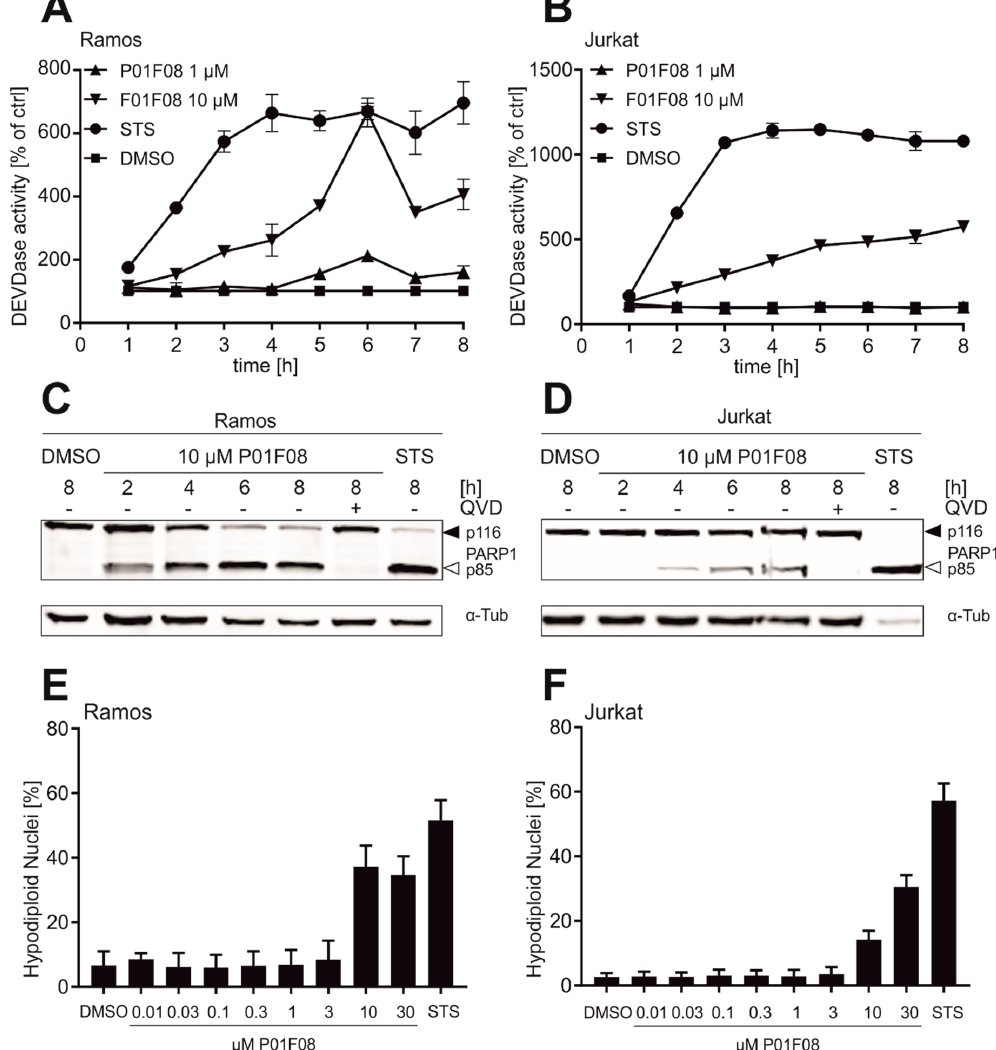
Figure 8. P01F08 is a potent inducer of apoptosis in leukemia and lymphoma cells with short latency and rapid kinetics especially in Ramos (lymphoma) cells. Ramos ( A ) and Jurkat ( B ) cells were treated with a high concentration of P01F08 (10 µM) or staurosporine (STS; 2.5 µM; positive control) for the induction of apoptosis for 8 h. Subsequently, DEVDase activity as a surrogate marker for caspase-3 activity was determined via measurement of the fluorescence of the profluorescent caspase-3 substrate DEVD-AMC in a micro-spectrophotometer. The slope of the linear range of fluorescence increase served as a measure for DEVDase activity. The DMSO control values were set to 100% and the normalized relative fold induction was calculated as described in Materials & Methods. ( A ) and ( B ) are representative for three independent experiments; mean and SD of triplicates are depicted. ( C ) and ( D ) show representative immunoblots of three independent experiments of cleavage of the caspase-3 substrate poly(ADP-ribose) polymerase 1 (PARP1; full-length 116 kDa, cleaved form 85 kDa) as an indicator for apoptotic cell death in Ramos cells ( C ) and Jurkat cells ( D ). Cells were treated with indicated concentrations of P01F08 (10 µM), DMSO (0.1% v / v ), and STS (2.5 µM) for the indicated incubation times alone or with pre-treatment (30 min) of the pan-caspase inhibitor QVD (10 µM). anti-Tubulin ( α -Tub) served as a loading control. ( E ) and ( F ) Apoptosis-related DNA degradation was detected after 24 h incubation via flowcytometric measurement of propidium iodide stained hypodiploid nuclei in ( E ) Ramos and ( F ) Jurkat cells. Mean and SD of three independent experiments performed in triplicates are depicted.